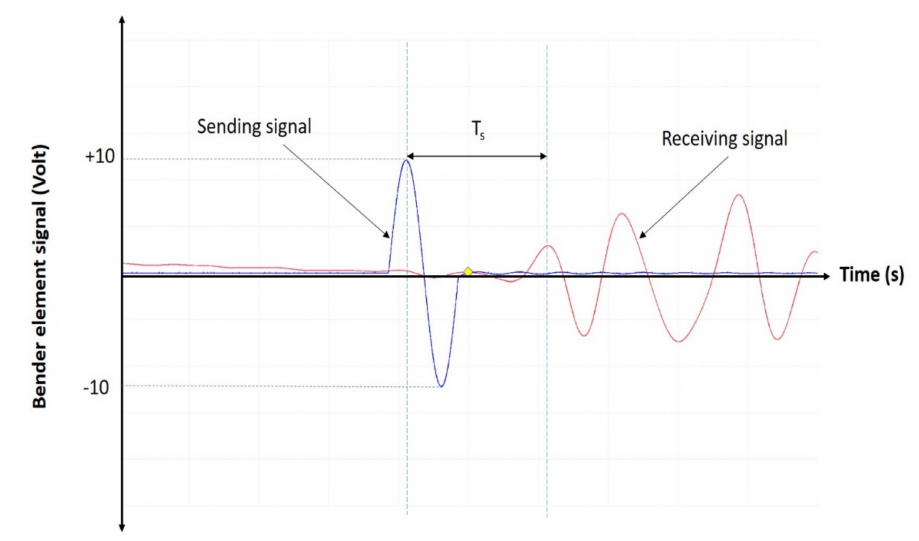
Figure 4. Example of sending and receiving shear waves.